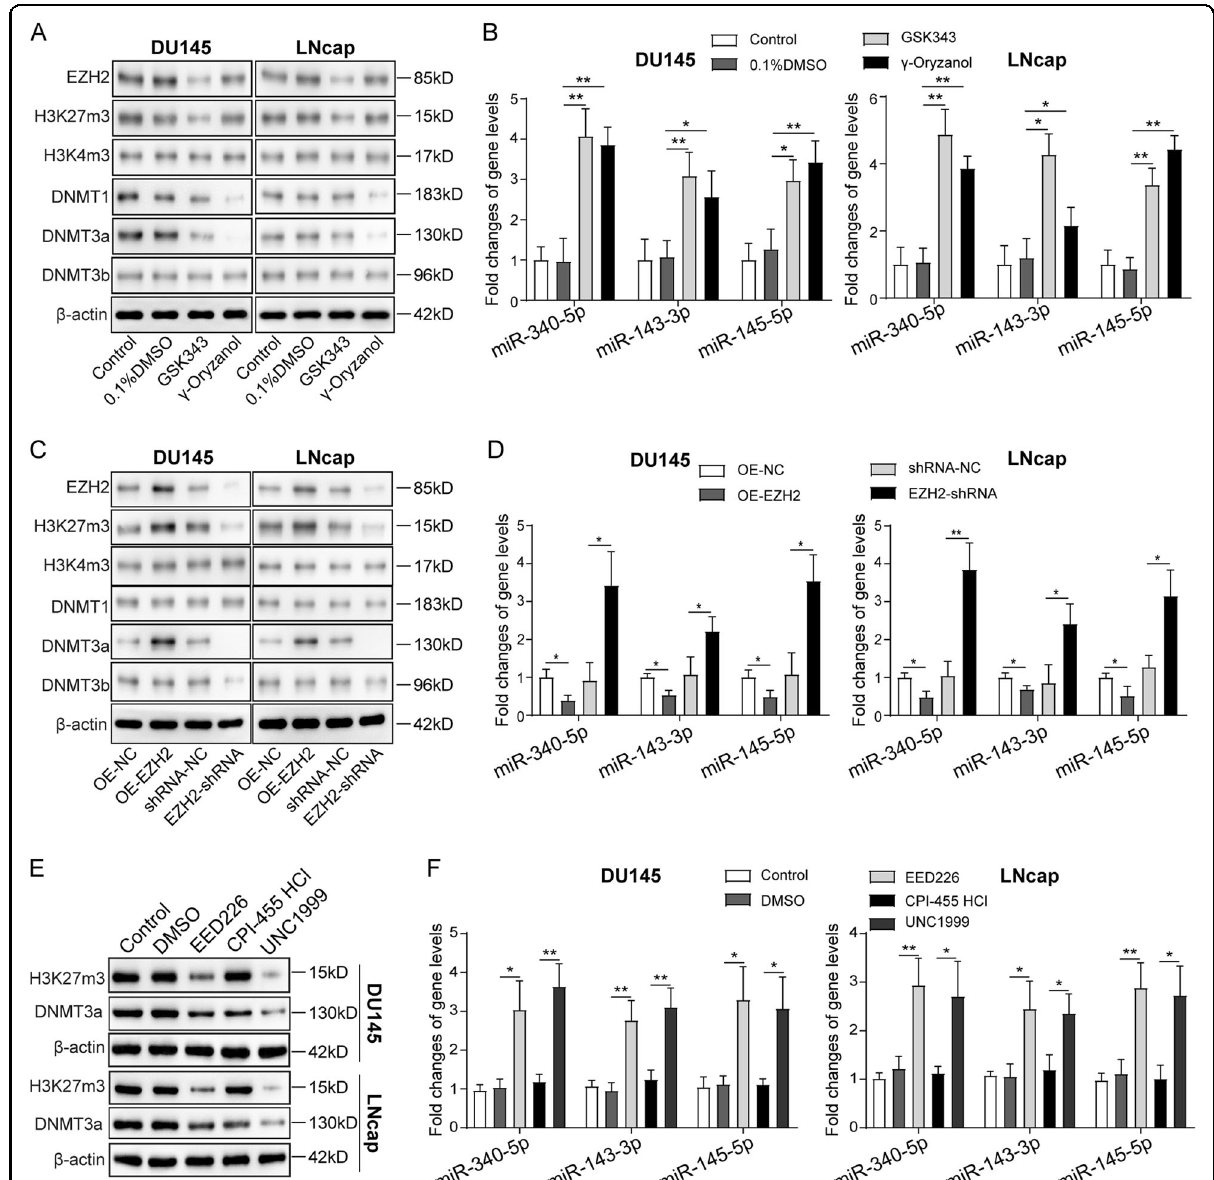
Fig. 3 EZH2-mediated regulation of histone methylation may be the main reason for expression inhibition of multiple miRNAs on chromosome 5 in prostate cancer cells. A Western blotting analysis of EZH2, H3K27me3, H3K4me3, DNMT1, DNMT3a, and DNMT3b in the DU145 and LNcap cells treated with inhibitor GSK343 or gamma-Oryzanol or not. B Western blotting analysis of EZH2, H3K27me3, H3K4me3, DNMT1, DNMT3a, and DNMT3b in the DU145 and LNcap cells with EZH2 overexpression or knockdown. C Western blotting analysis of H3K27me3 in the DU145 and LNcap cells treated with EED226 or UNC1999 for H3K27me3 knockdown or treated with H3K4me3 inhibitor CPI-455 HCl. D QPCR analysis for the expression of miR-340-5p, miR-145-5p, and miR-143-3p in DU145 and LNcap cells treated with inhibitor GSK343 or gamma-Oryzanol or not. E QPCR analysis for the expression of miR-340-5p, miR-145-5p, and miR-143-3p in DU145 and LNcap cells with EZH2 overexpression or knockdown. F QPCR analysis for the expression of miR-340-5p, miR-145-5p, and miR-143-3p in DU145 and LNcap cells treated with EED226 or UNC1999 for H3K27me3 knockdown or treated with H3K4me3 inhibitor CPI-455 HCl. The results are presented as the mean ± SD. * P < 0.05, ** P < 0.01. EZH2 Enhancer of Zeste Homolog 2, H3K27me3 histone 3 lysine 27 tri-methylation, H3K4me3 histone 3 lysine 4 tri-methylation, DNMT DNA